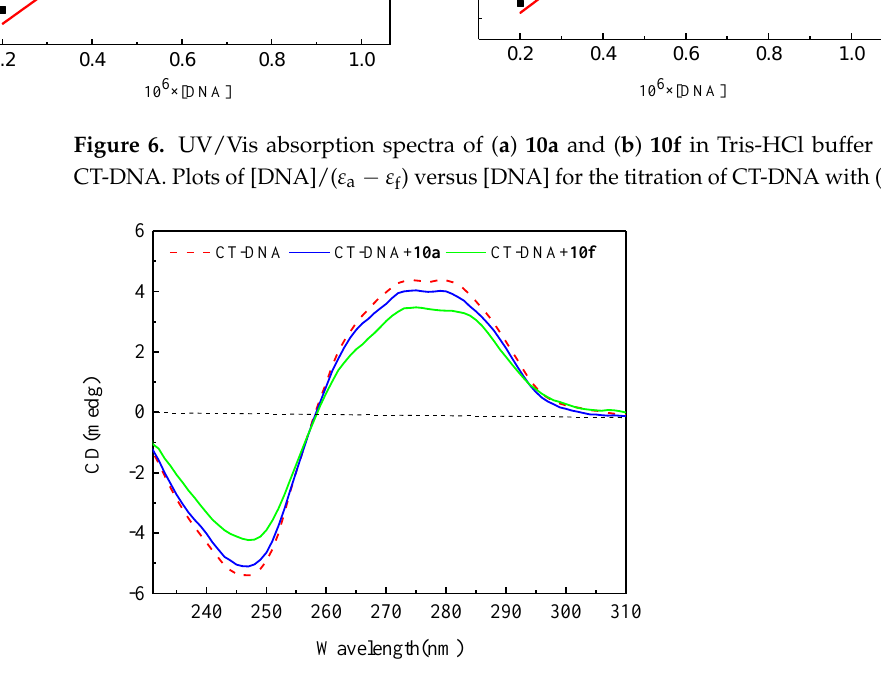
Figure 7. CD spectra of CT-DNA (600 μM) in the absence and presence of 10a or 10f (100 μM).